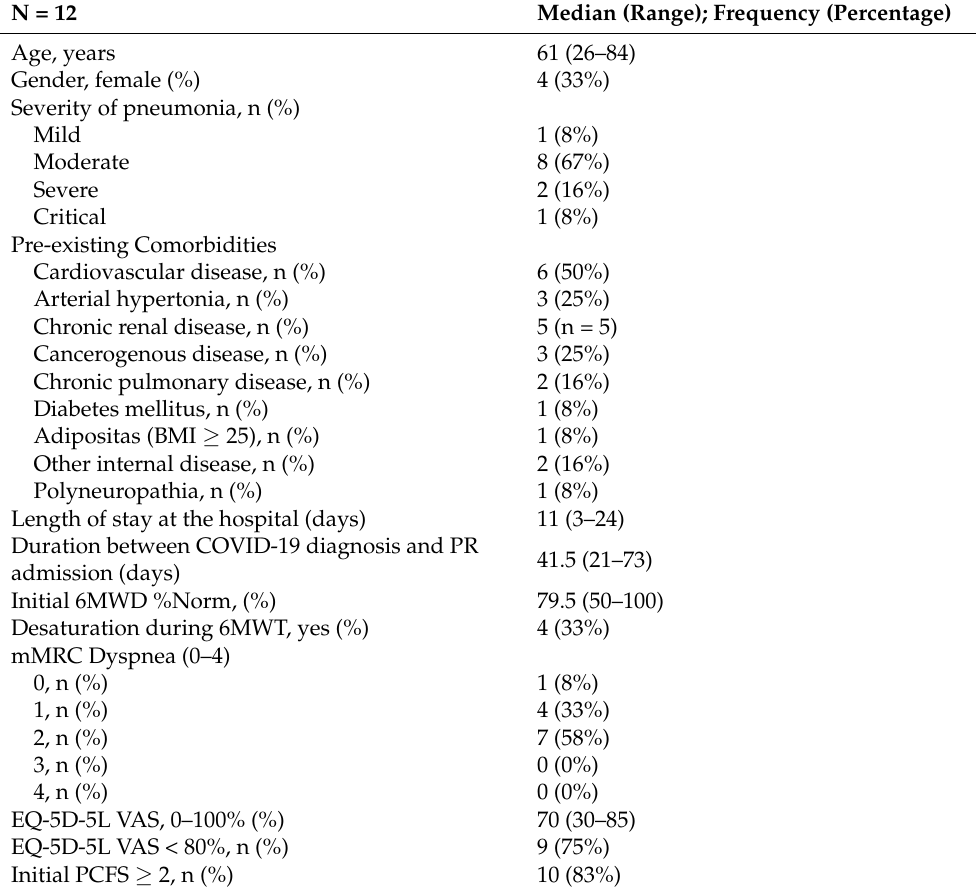
Table 2. Patients’